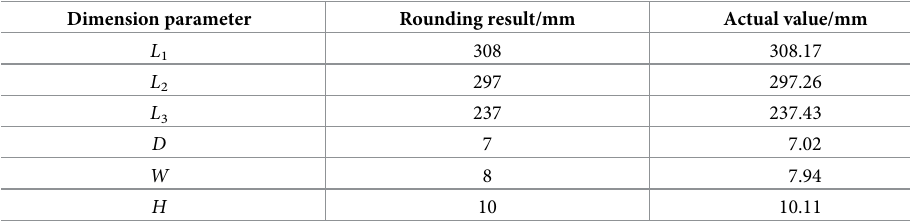
The optimal choice for the best bed structure optimization solution is Candidate A follow- ing comparison analysis. The optimal solutions for the width W and height H of inner wall ribs in the workbench, using the same optimization solution process, are 7.94 mm and 10.11 mm, respectively. The parameters of each dimension are correctly rounded for the conve- nience of the real product design and manufacture, and the results are displayed in Table 6. Table 6. Roundness results of optimization